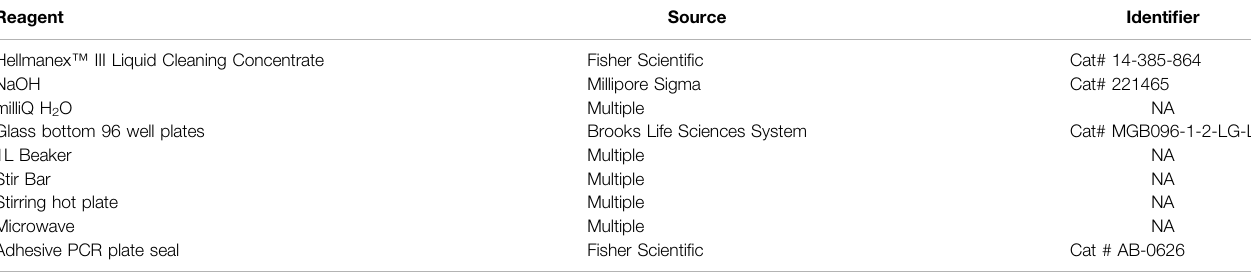
TABLE2| Reagentsforcleaning96-wellglass-bottomplates.Manychemicalsandsupplieshavenumerousoptionsavailablefrommultiplecompanies.Wehavelistedsome of the speci fi c items we have used to perform these assays.